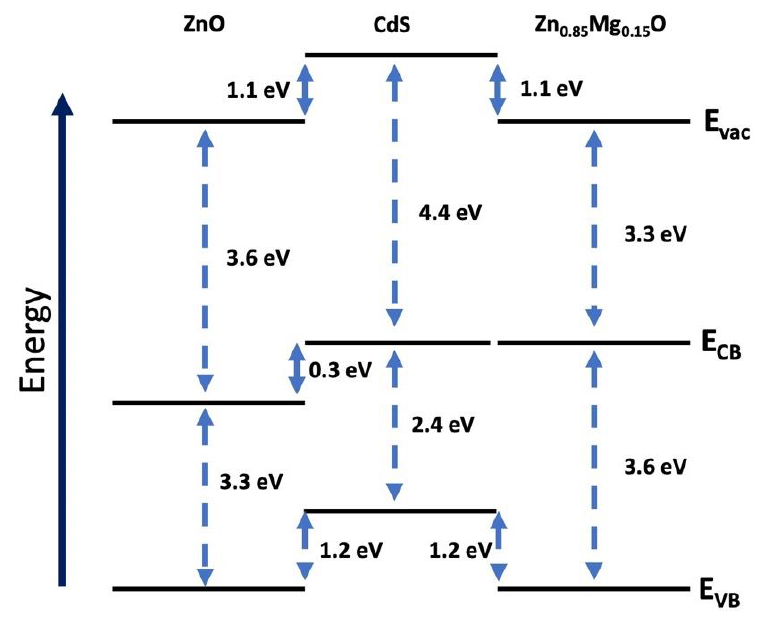
Figure 13. Band alignment of CdS with ZnO and with MZO [94].